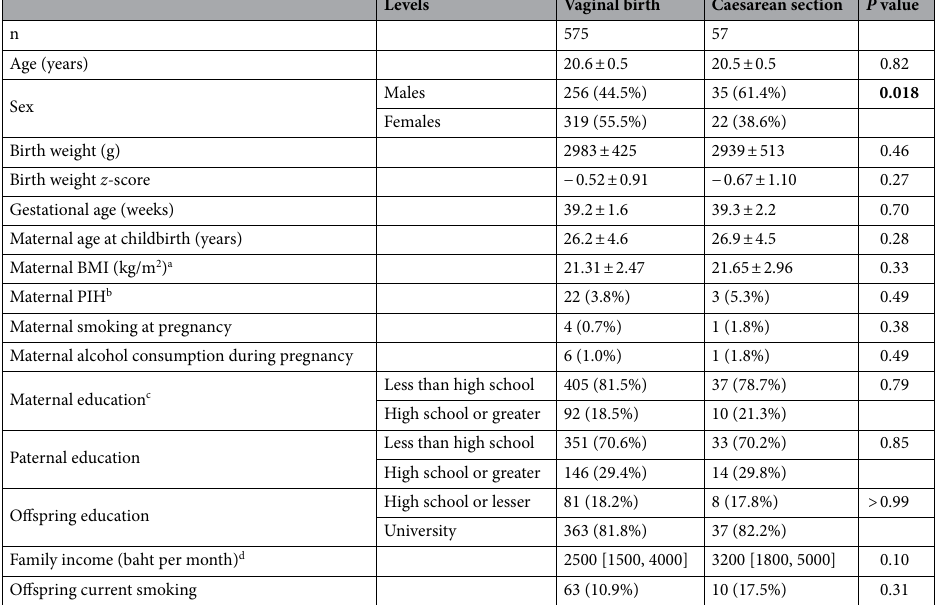
Table 2. Demographic and birth characteristics of the study population according to the mode of delivery. Continuous data are means ± SD or median [quartile 1, quartile 3], as appropriate; categorical data are n (%). BMI body mass index, PIH pregnancy-induced hypertension. P values that are statistically significant (at p < 0.05) are shown in bold. a BMI recorded at the first antenatal visit in the original study in 1989–1990. b PIH was defined as a systolic blood pressure ≥ 140 mmHg and/or diastolic blood pressure ≥ 90 mmHg developed after 20 weeks of gestation without proteinuria, in a previously normotensive woman. c There were missing data on the highest level of education, so that the available sample sizes for the vaginal birth and caesarean section groups, respectively, were: maternal education [497 (86.4%) and 47 (82.5%)], paternal education [49 (86.4%) and 47 (82.5%)], and offspring education [444 (77.2%) and 45 (78.9%)]. d Income recorded at the time of maternal recruitment to the original study in 1989–1990 (i.e., not adjusted for inflation); the available sample sizes were 495 (86.1%) for the vaginal birth group and 47 (82.5%) for the caesarean section